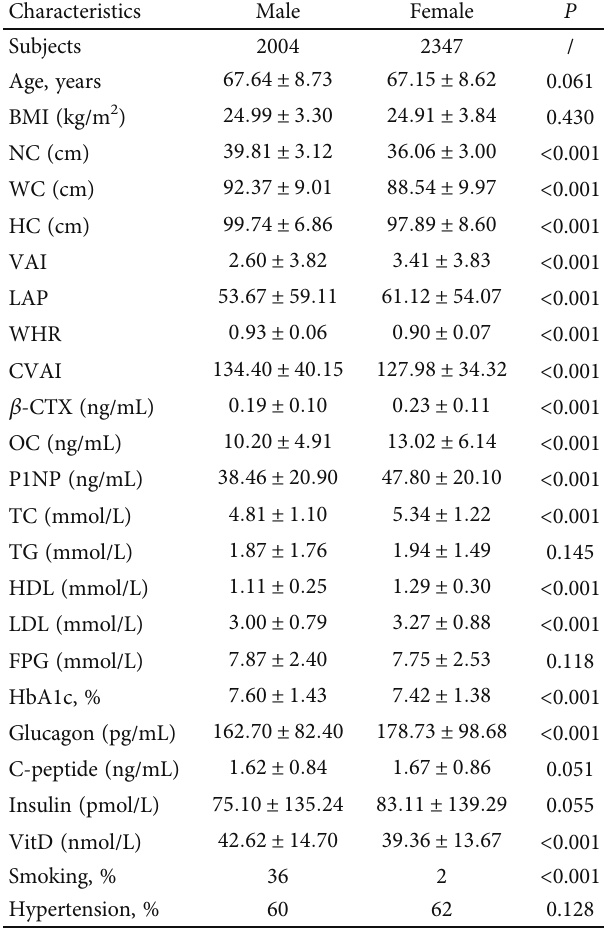
Table 1: General characteristics of all male and female participants.